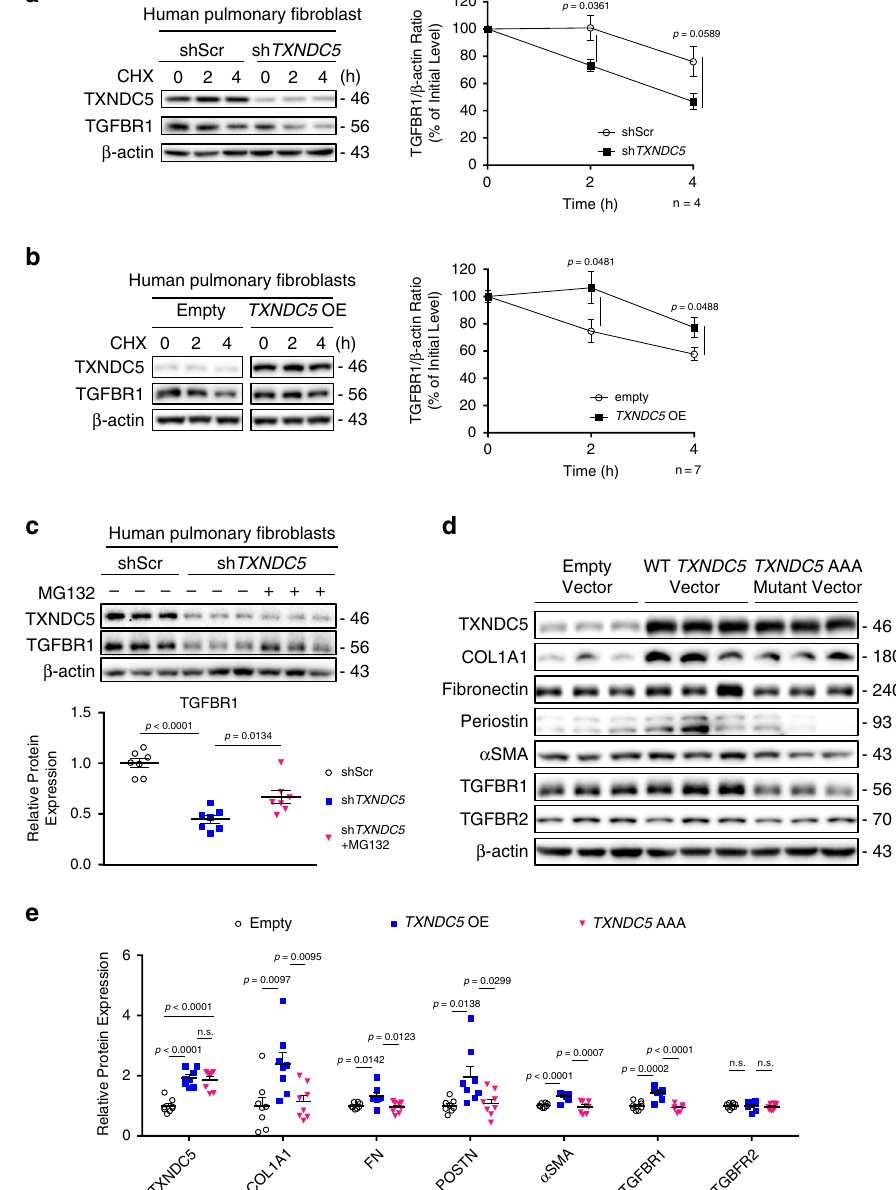
Fig. 8 TXNDC5 promotes fi brogenesis by enhancing TGFBR1 protein stability via its PDI activity. a A cycloheximide chase assay performed in HPF